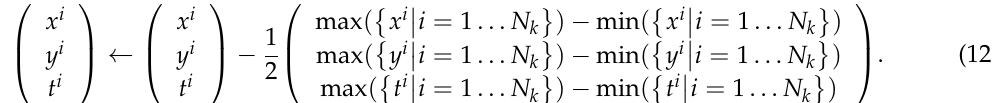
Figure 1. The candidate direction of 3D-lines after three icosahedron subdivision steps.